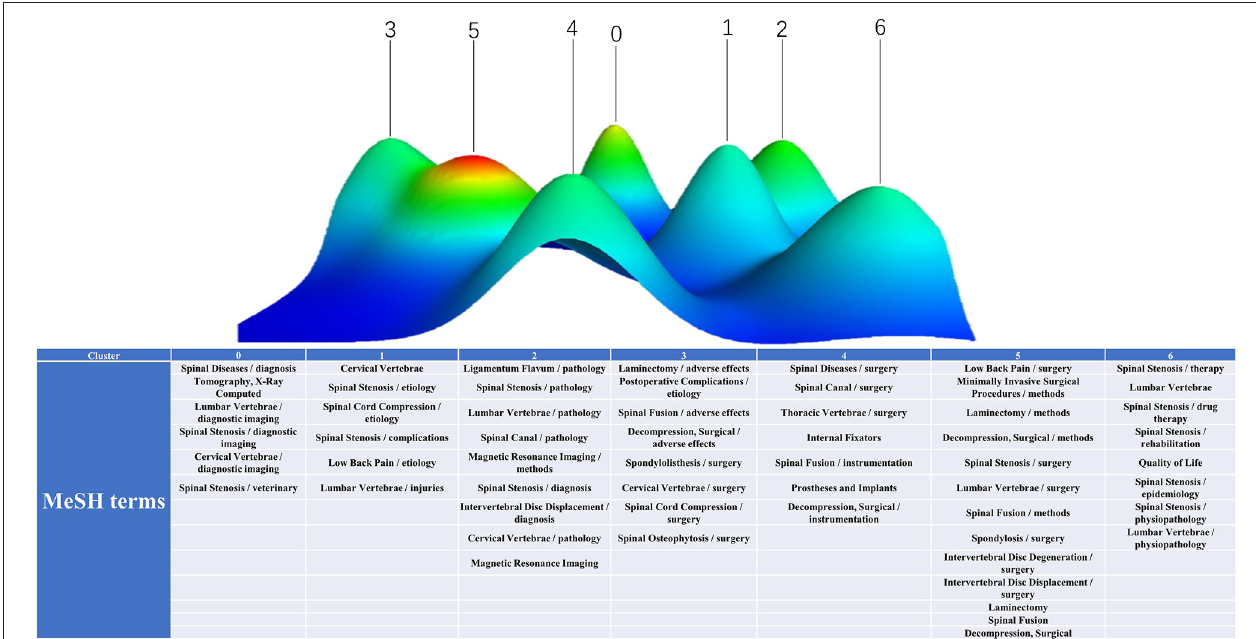
FIGURE 9 | Mountain visualization of biclustering of high-frequency major MeSH terms and articles on spinal